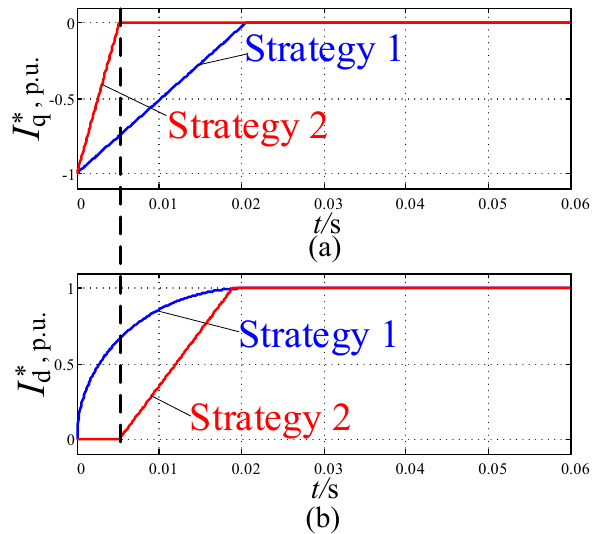
Figure 6. Two different strategies for reactive current exit. ( a ) q-axis current reference strategy, ( b ) d-axis current reference strategy.